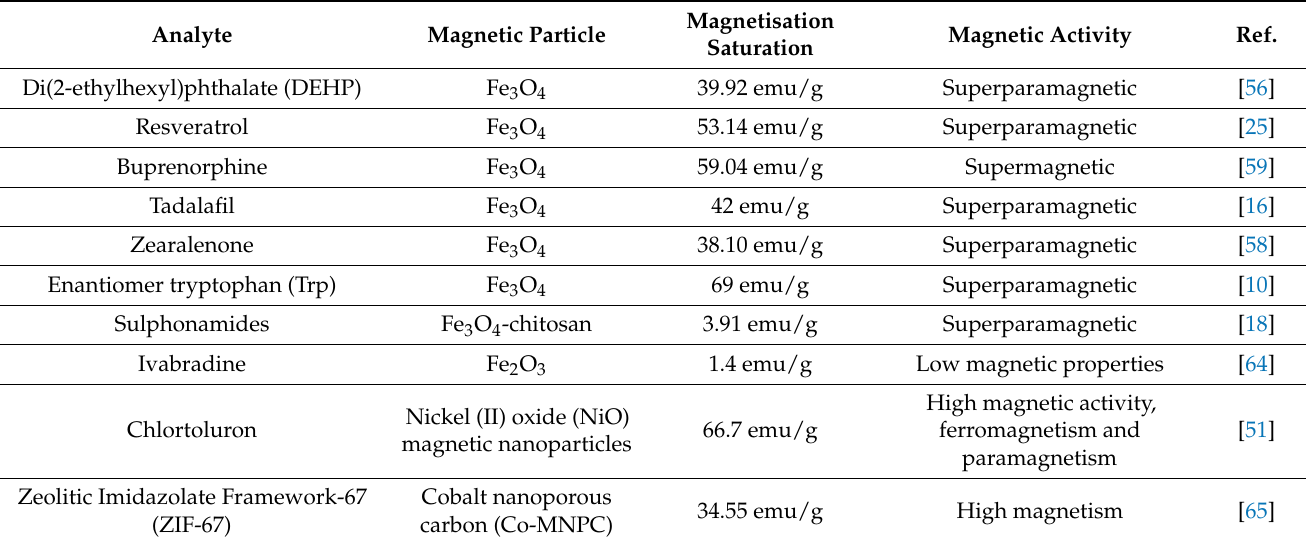
Table 1. Summary of the MMIP methods using Fe, Ni and Co magnetic